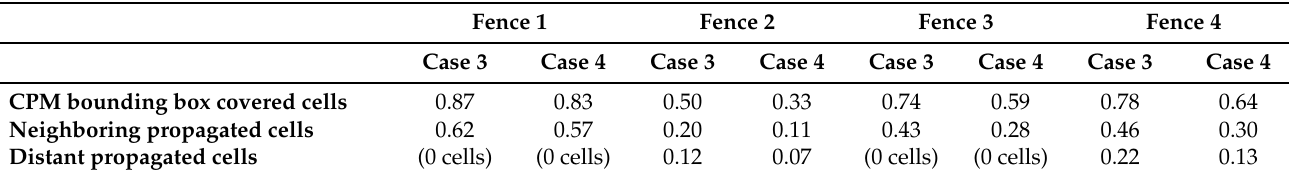
Figure 9. Occupancy grid under different uncertainties. Table 2. Mean occupancy probability estimated for the fences.